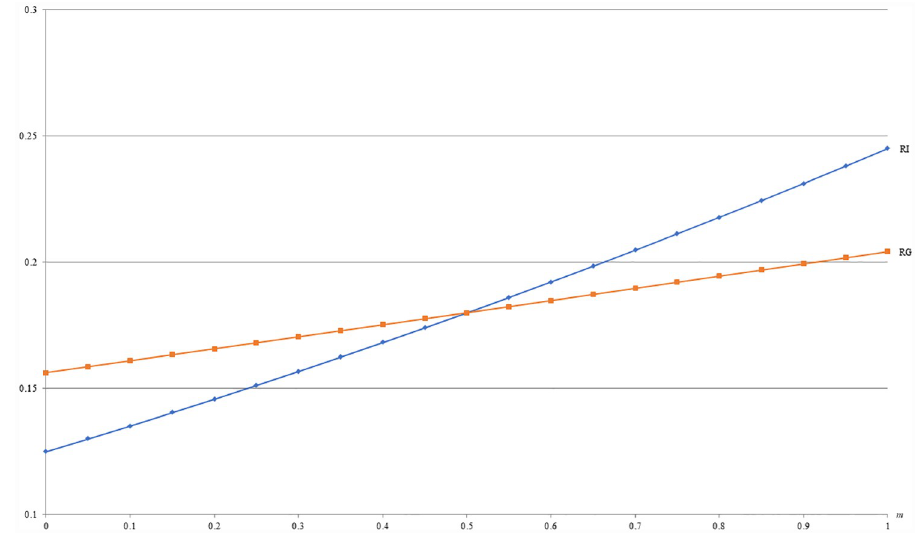
Fig 7. A comparison of revenues between IB and GB with respect to m